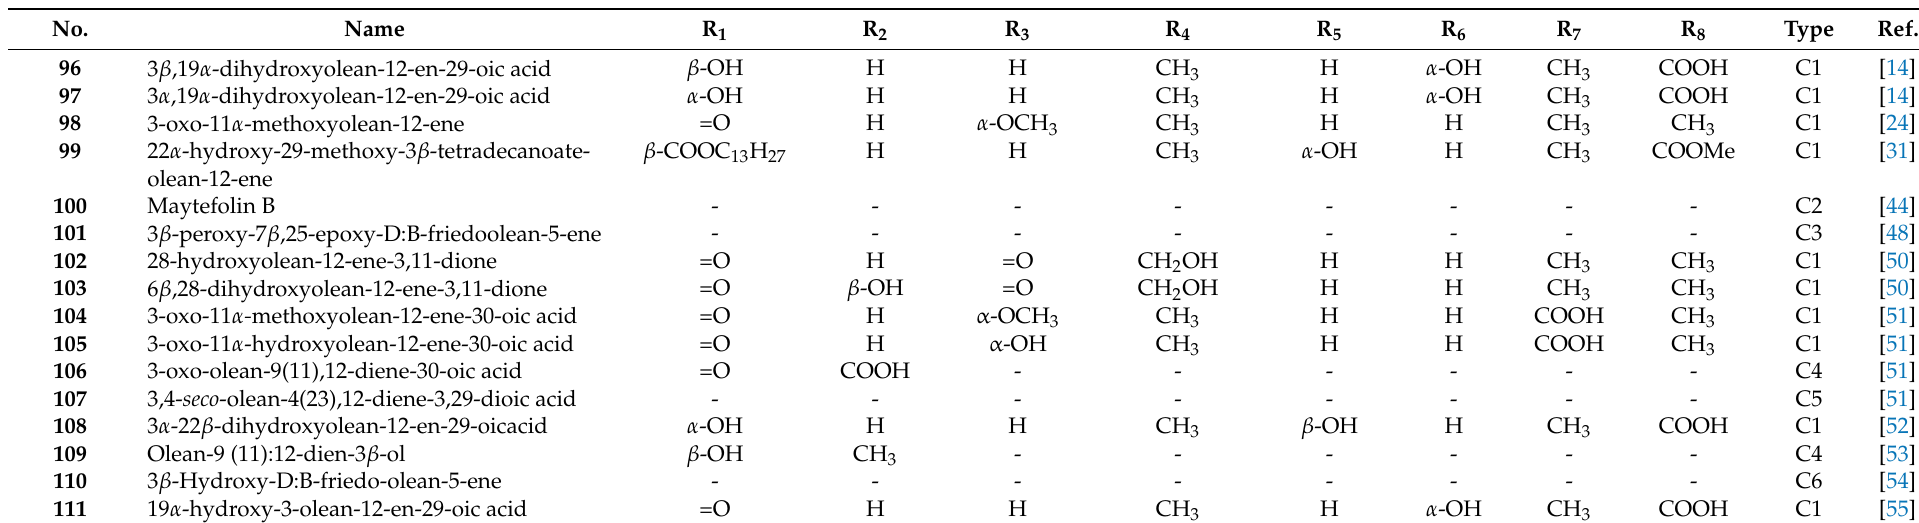
Table 3. The oleanane triterpenes isolated from Maytenus